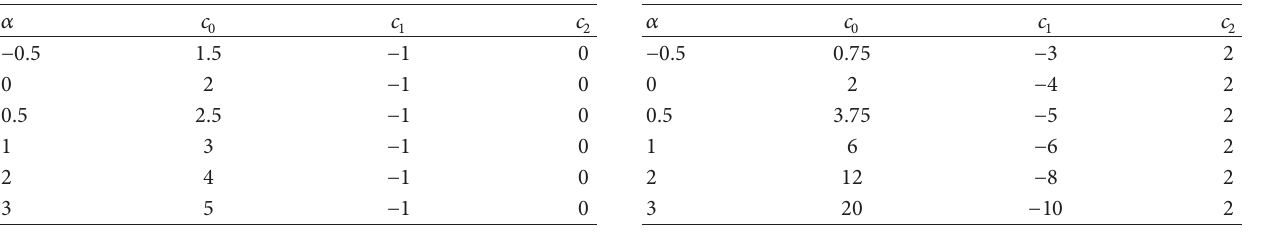
Table 1: 𝑐 0 , 𝑐 1 , and 𝑐 2 for different values of 𝛼 for Example 1. Table 2: 𝑐 0 , 𝑐 1 , and 𝑐 2 for different values of 𝛼 for Example